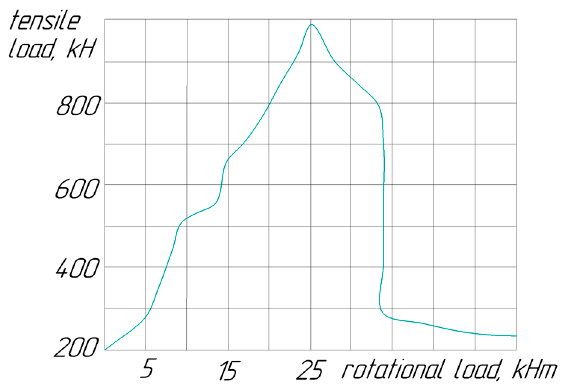
Figure 6. Graph of first application of rotational load.